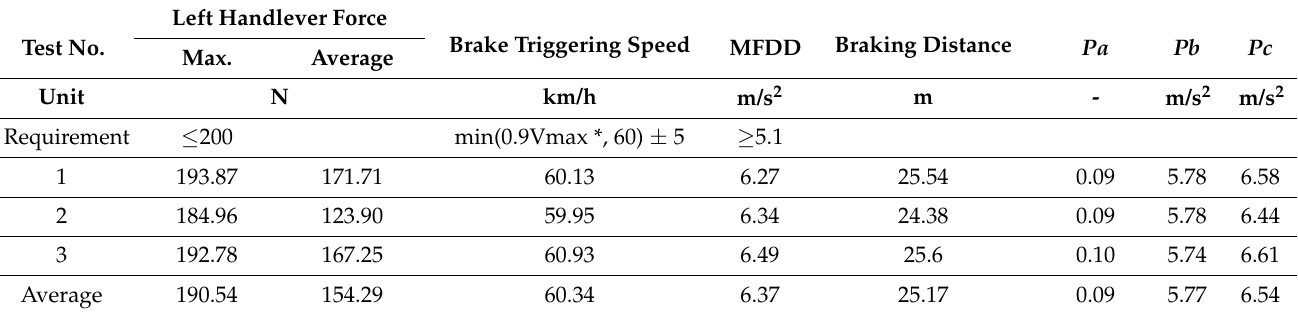
Table 2. Brake distance and deceleration at laden load.